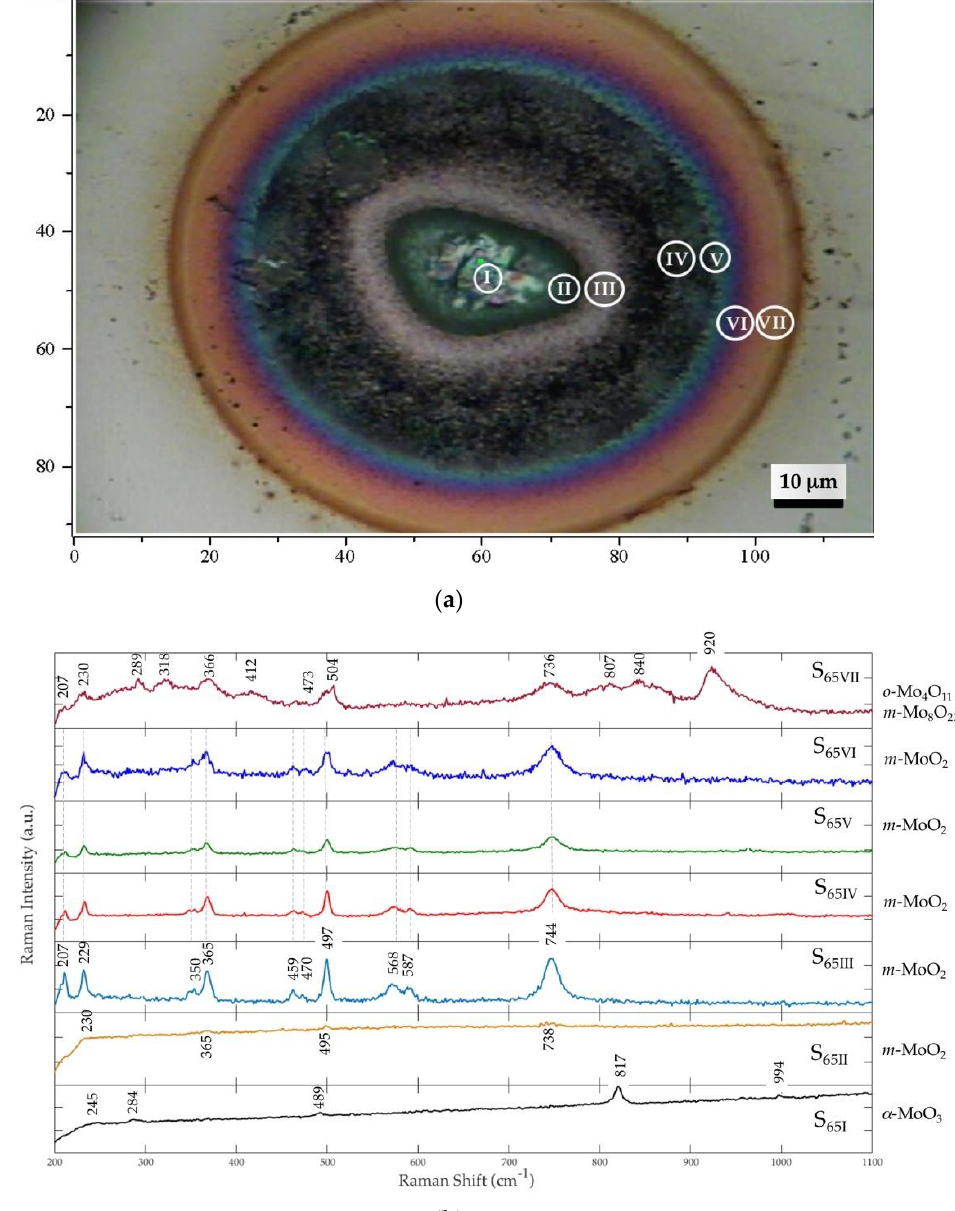
Figure 7. Optical micrograph ( a ) with I–VII the positions where Raman measurements were taken, and spatially resolved Raman spectra ( b ) for the irradiated spot S 65 at per-pulse laser fluence 4.2 mJ / cm 2 and 1 min exposure